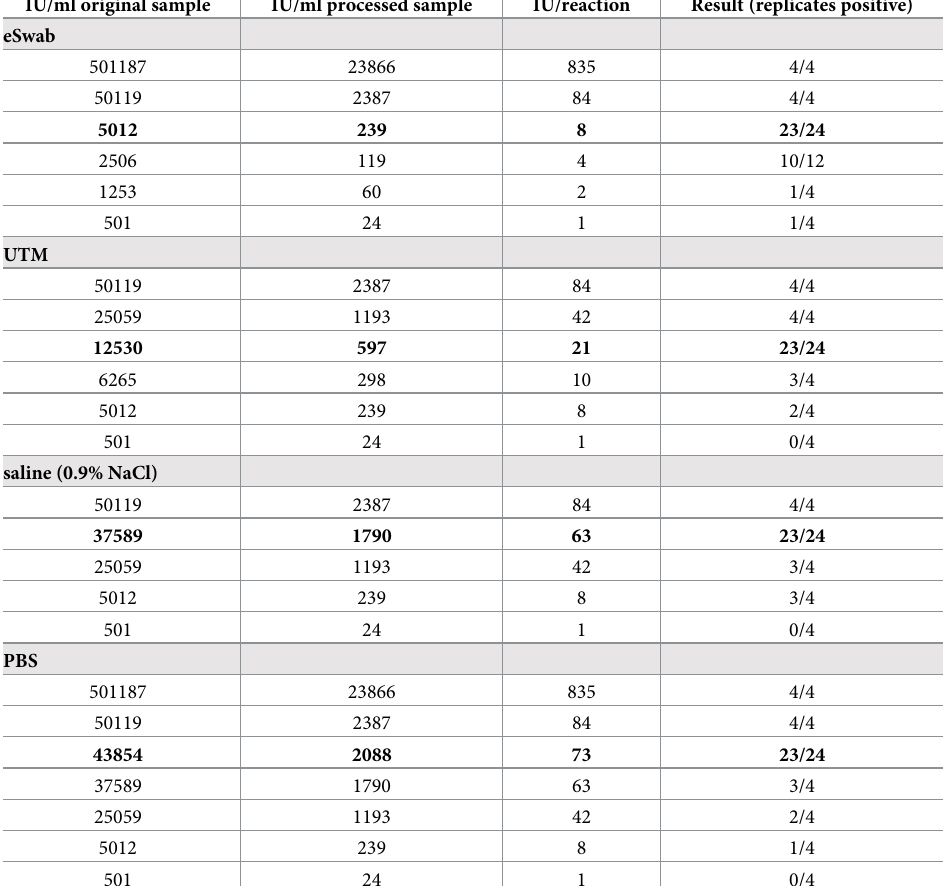
Table 2. Limits of detection of the GenomEra SARS-CoV-2 assay using SARS-CoV-2 genomic RNA spiked in nasopharyngeal swabs collected in four transport